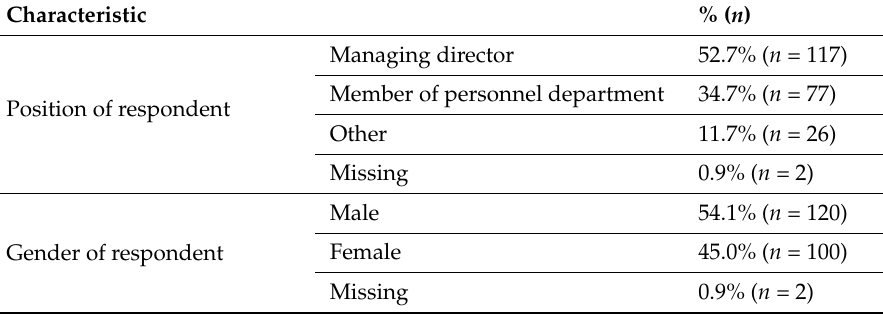
Table 3. Sociodemographic characteristics of